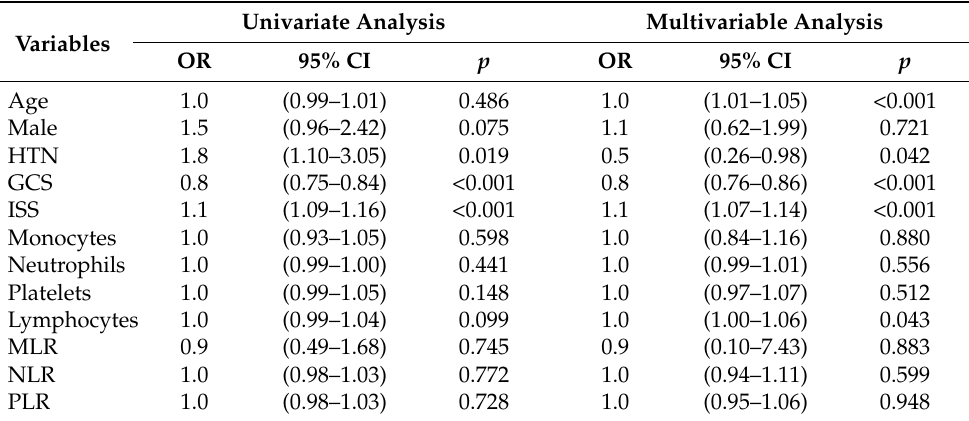
Table 3. Results of the univariate and multivariate analyses to identify independent risk factors for mortality in patients with